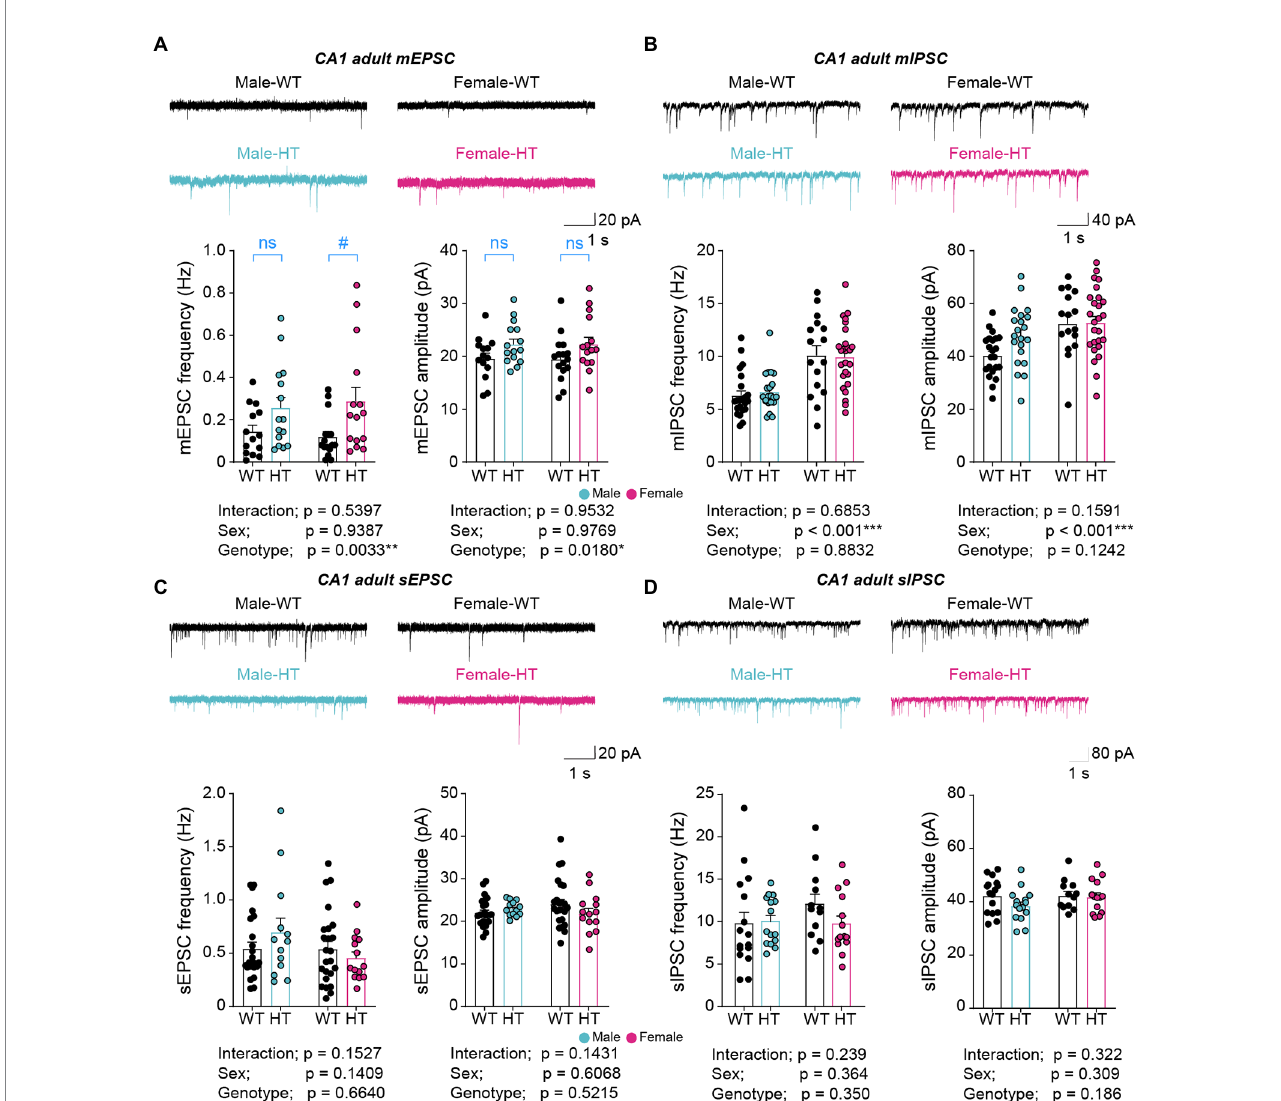
FIGURE 1 Increased excitatory synaptic transmission in adult Chd8+/S62X males and females. (A) mEPSCs in CA1 pyramidal neurons in adult Chd8 +/S62X males and females (15–18 weeks). ( n = 14 neurons from 3 mice [male-WT], 15/4 [male-HT], 16/4 [female-WT], and 15/3 [female-HT], * p < 0.05, ** p < 0.01, two-way ANOVA, # p < 0.05, ns, not significant, Mann–Whitney U- test). (B) mIPSCs in CA1 pyramidal neurons in adult Chd8 +/S62X males and females (13–16 weeks). ( n = 22/4 [male-WT], 21/5 [male-HT], 16/3 [female-WT], and 26/4 [female-HT], *** p < 0.001, two-way ANOVA). (C) sEPSCs in CA1 pyramidal neurons in adult Chd8 +/S62X males and females (13–16 weeks). ( n = 14/3 [male-WT], 15/4 [male-HT], 16/4 [female-WT], and 15/3 [female-HT], two-way ANOVA). (D) sIPSCs in CA1 pyramidal neurons in adult Chd8 +/S62X males and females (13–16 weeks). ( n = 16/3 [male-WT], 15/3 [male-HT], 12/3 [female-WT], and 14/3 [female-HT], two-way